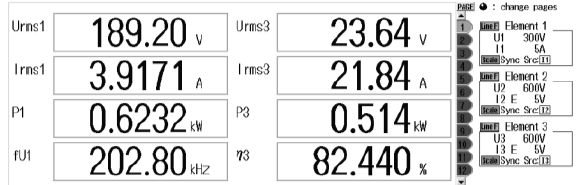
Figure 19. Output characteristics with UAV.